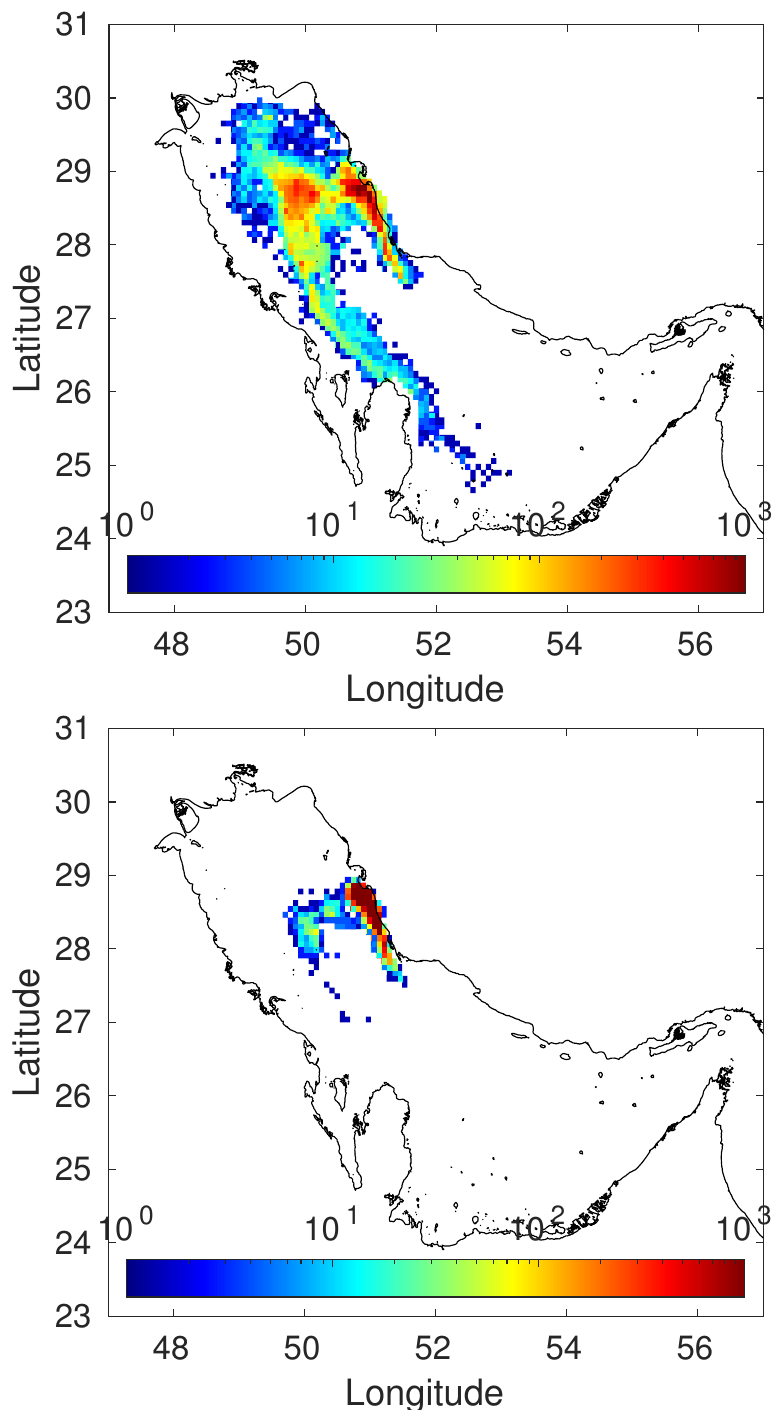
Figure 4. Modeled distributions in seabed sediments (units/kg) of a hypothetical tracer released in the Persian Gulf if simulated with a k d model ( top ) and a dynamic model ( bottom ). The release was considered constant in time and lasting 90 days. Results after these 90 days are